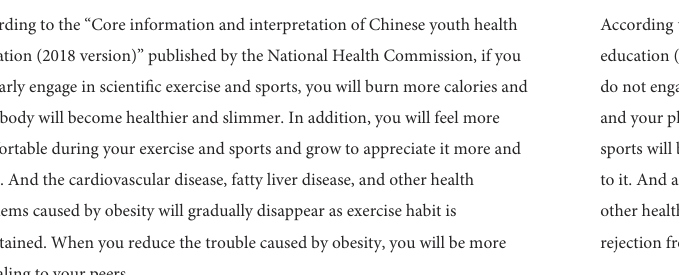
TABLE 1 Framed messages (translated from